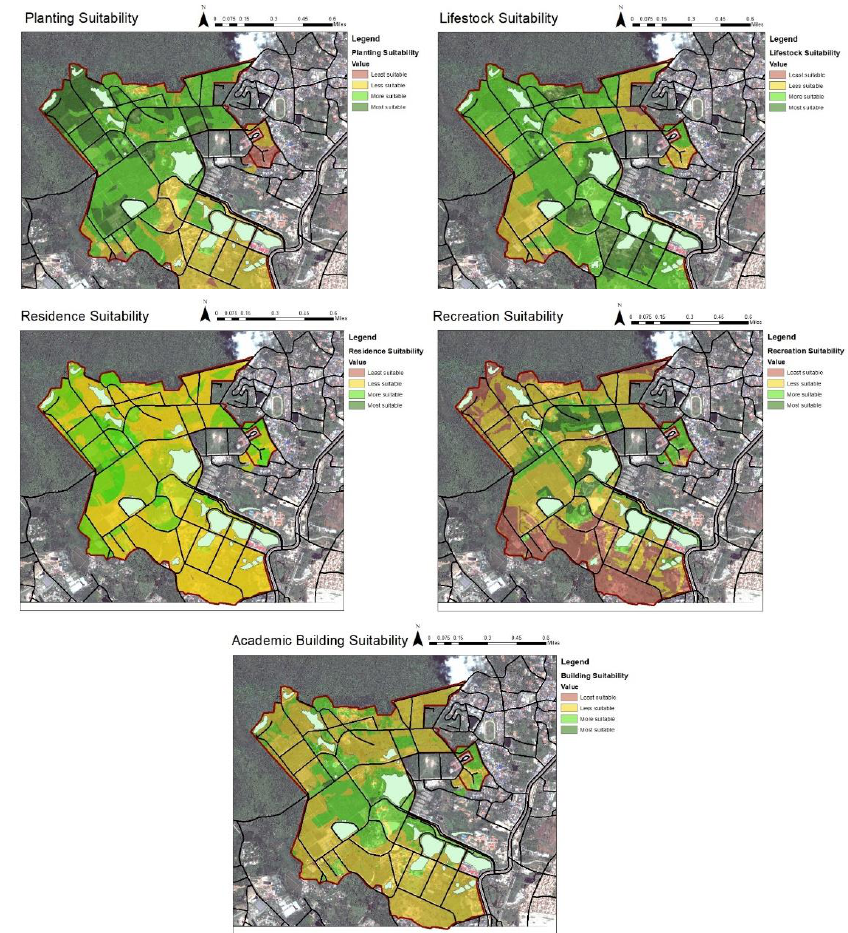
Figure 6. The suitability analysis criteria.